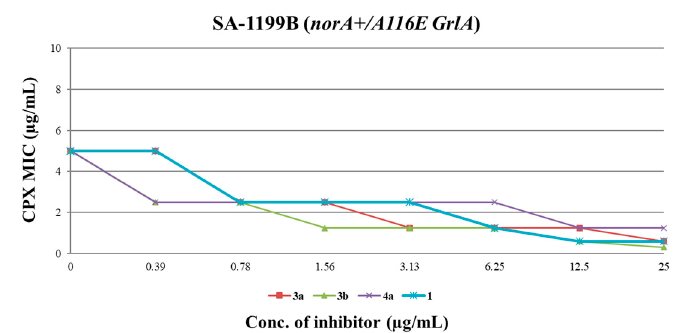
Figure 4. CPX MIC reduction against SA-1199B in the presence of increasing (doubling) concentrations of derivatives 3a , 3b , 4a and starting hit 1 . A ≥ 4-fold MIC reduction was considered as synergism. Table 2. EtBr e ffl ux inhibition (%) on SA-1199B exerted by compounds 3a , 3b and 4a .